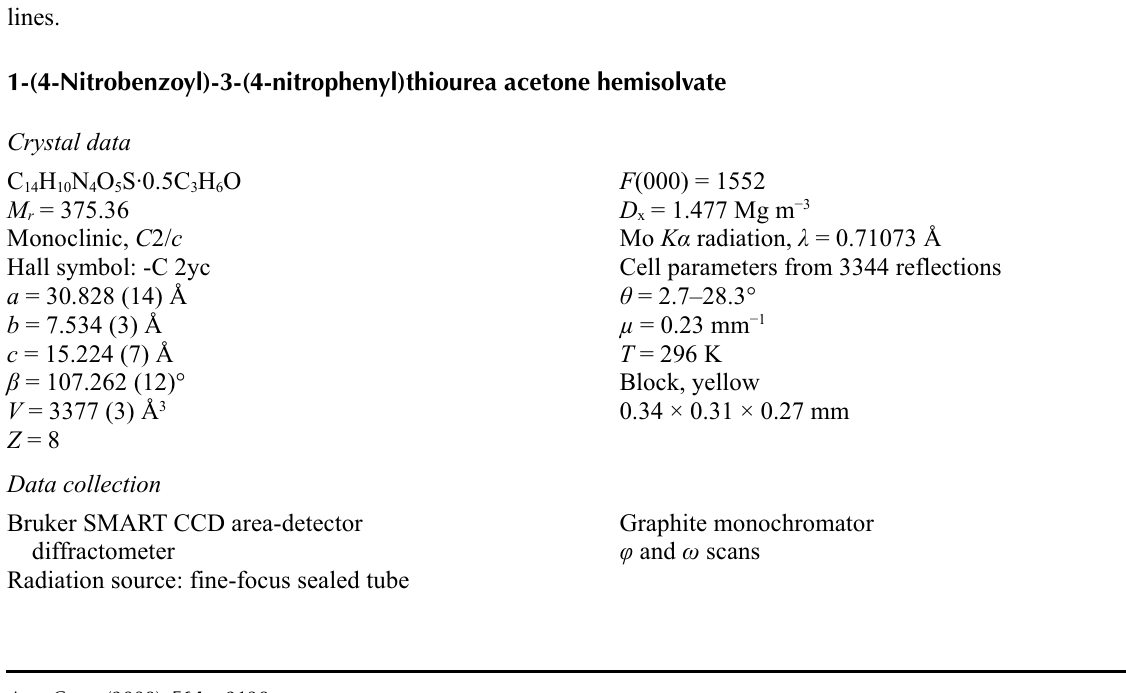
Packing diagram of the title compound viewed along the a axis. Intermolecular hydrogen bonds are shown as dashed